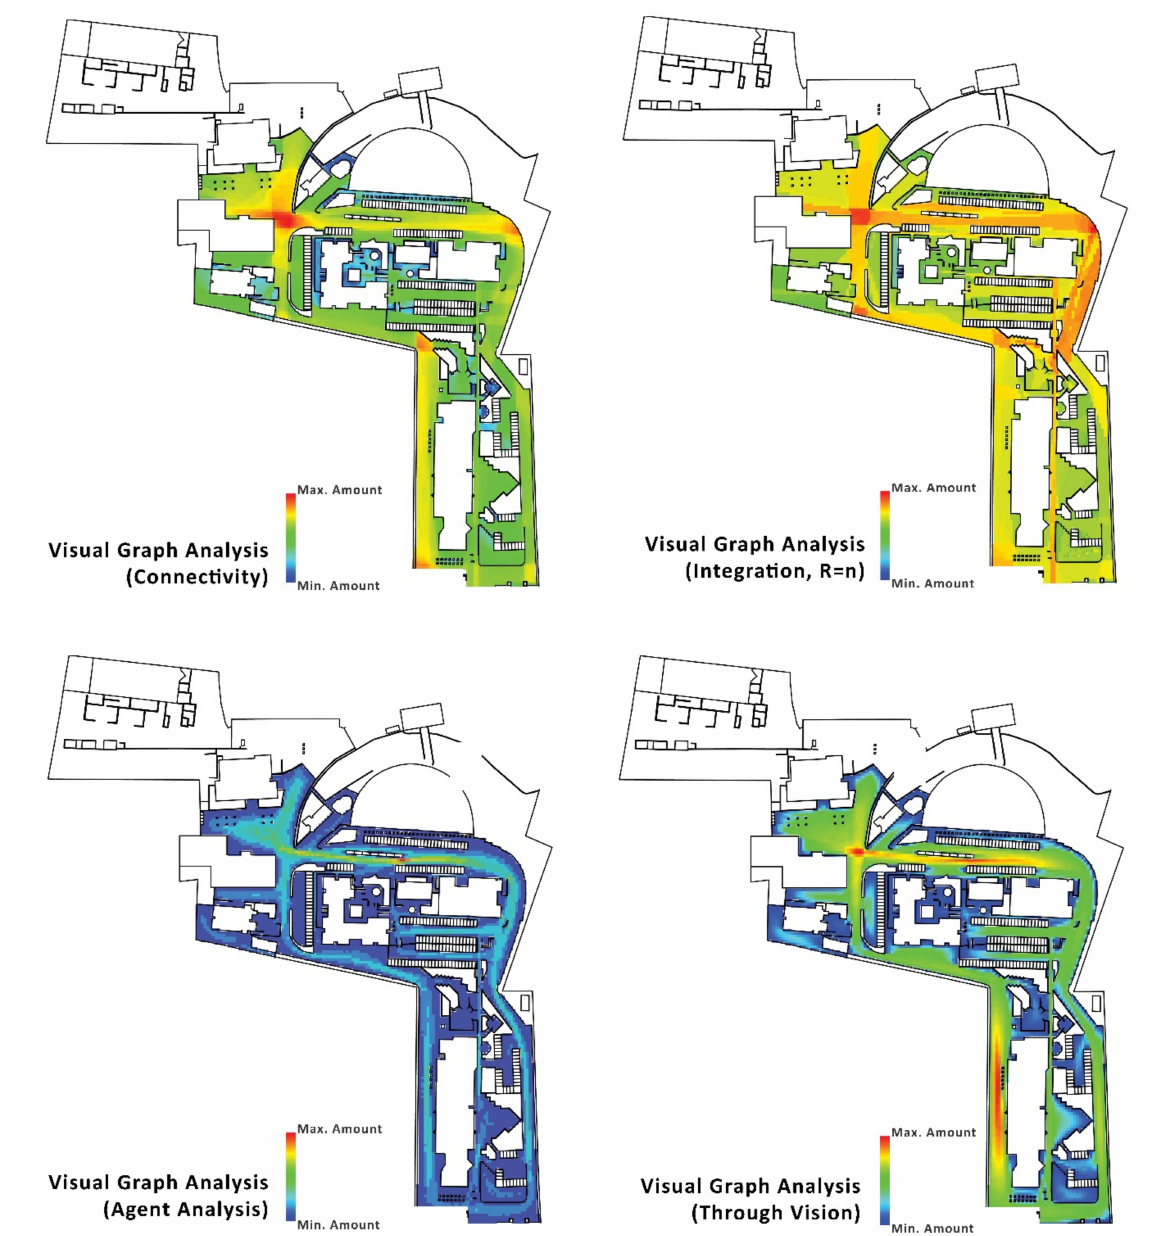
Figure 4. Visibility graph analysis (VGA) for the academic section of the